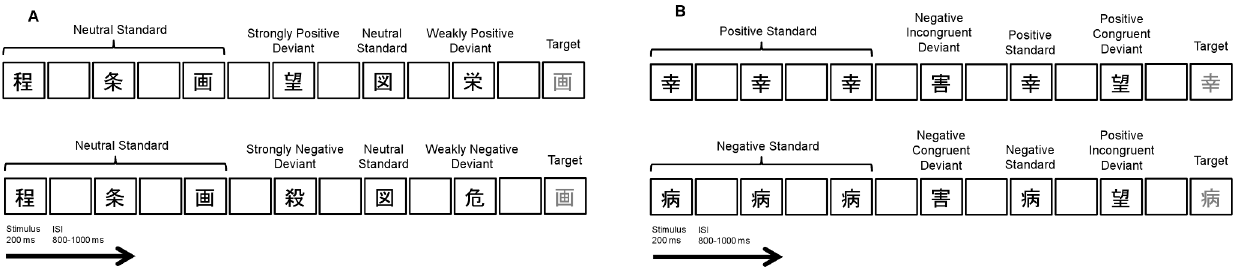
Figure 1. The sequence of stimuli for the two experimental paradigms. The duration of each stimulus was 200 ms. The inter-stimulus interval (ISI) was altered within 800–1000 ms. (A) The two sequences for Experiment 1. Strongly positive (negative) deviants and weakly positive (negative) deviants were infrequently presented in a sequence of neutral standards. All types of Japanese kanji consisting of standards and deviants were presented in the same frequency in the sequence. (B) The positive and negative sequences for Experiment 2. Positive deviants and negative deviants were infrequently presented in a sequence of standards. In the sequence of positive standards, positive deviants served as emotionally congruent deviants and negative deviants served as emotionally incongruent deviants. In the sequence of negative standards, negative deviants served as emotionally congruent deviants and positive deviants served as emotionally incongruent deviants.